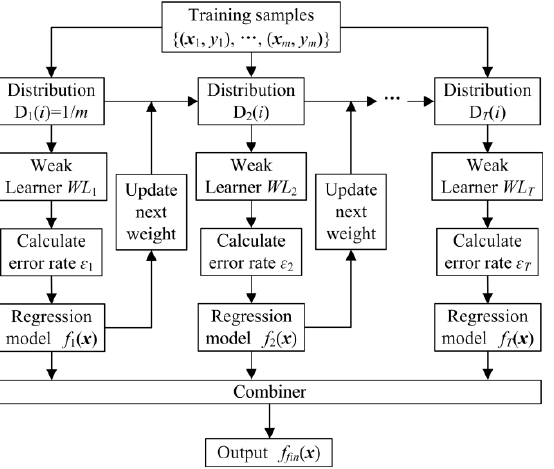
Figure 3. Ensemble ELM model based on self-adaptive AdaBoost.RT algorithm.